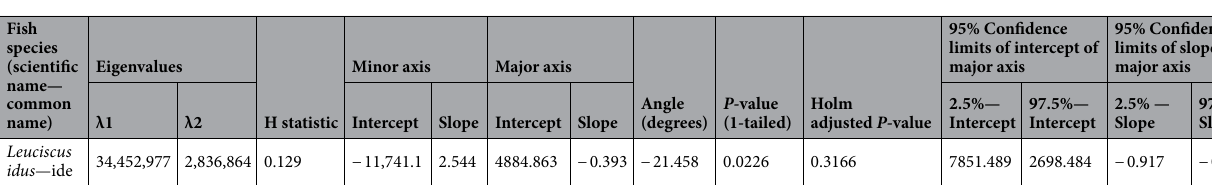
Figure 6. Carassius gibelio— Prussian carp biomass as a function of Leuciscus idus— ide biomass (both Hellinger transformed) in the recovered course of the Ner River, Poland, in subsequent sampling surveys over the period of 2000–2012. Green dots are biomass values in given surveys, while green numbers in brackets are years of the surveys. Red solid line is the major axis (of the bivariate distribution and of the ellipse). Red dashed lines are 95% confidence limits of the major axis. Black dotted line is the minor axis. The blue ellipse is 95% confidence region of the mean of both variables. Blue dots (marked by blue letters, ‘A…H’), are characteristic points of the ellipse. The coordinates of the points (e.g. ‘A (x, y) =’) are also indicated, x being the abscissa, y the ordinate axis location.